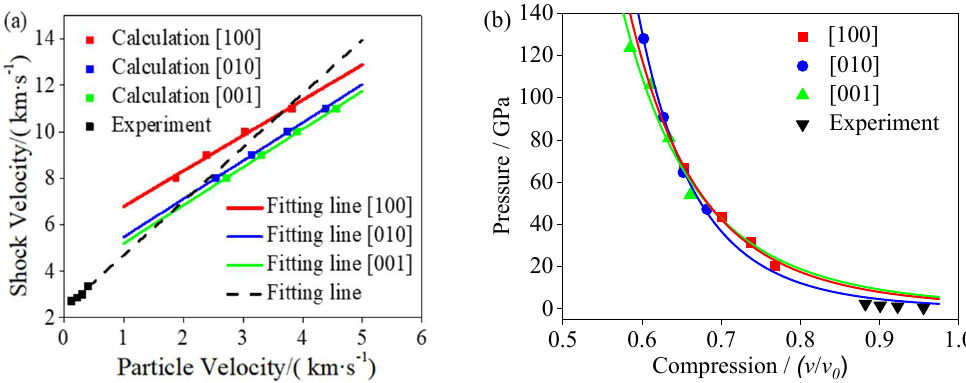
Figure 2. ( a ) Relationship between TNAZ shock velocity and particle velocity. ( b ) Relationship between pressure and specific volume.